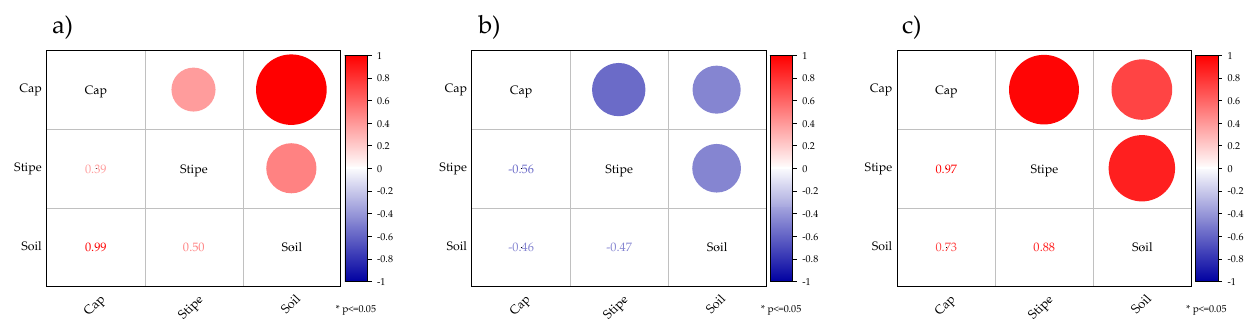
Figure 2. Correlation between Cd contents in the soil, cap, and stipe parts of Tricholoma spp. (( a ) T. columbetta , ( b ) T. portentosum , and ( c ) T. terreum ); * indicates level of significance ( p < 0.05); refer to the color scale bar for interpretation of correlation coefficient values as text and circles